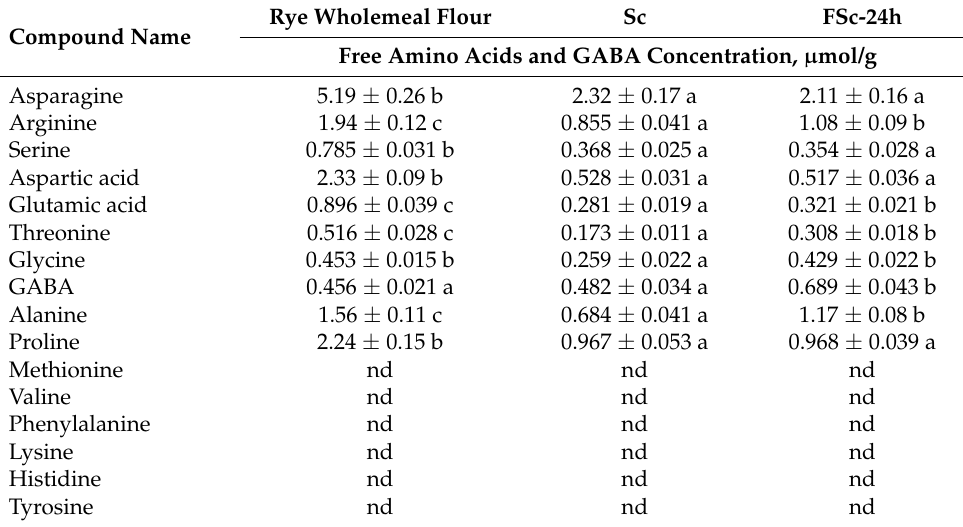
Table 4. Free amino acid profile and gamma aminobutyric acid (GABA) concentration in rye whole- meal flour and in scalded (Sc) and scalded-fermented (FSc) (after 24 h) rye wholemeal